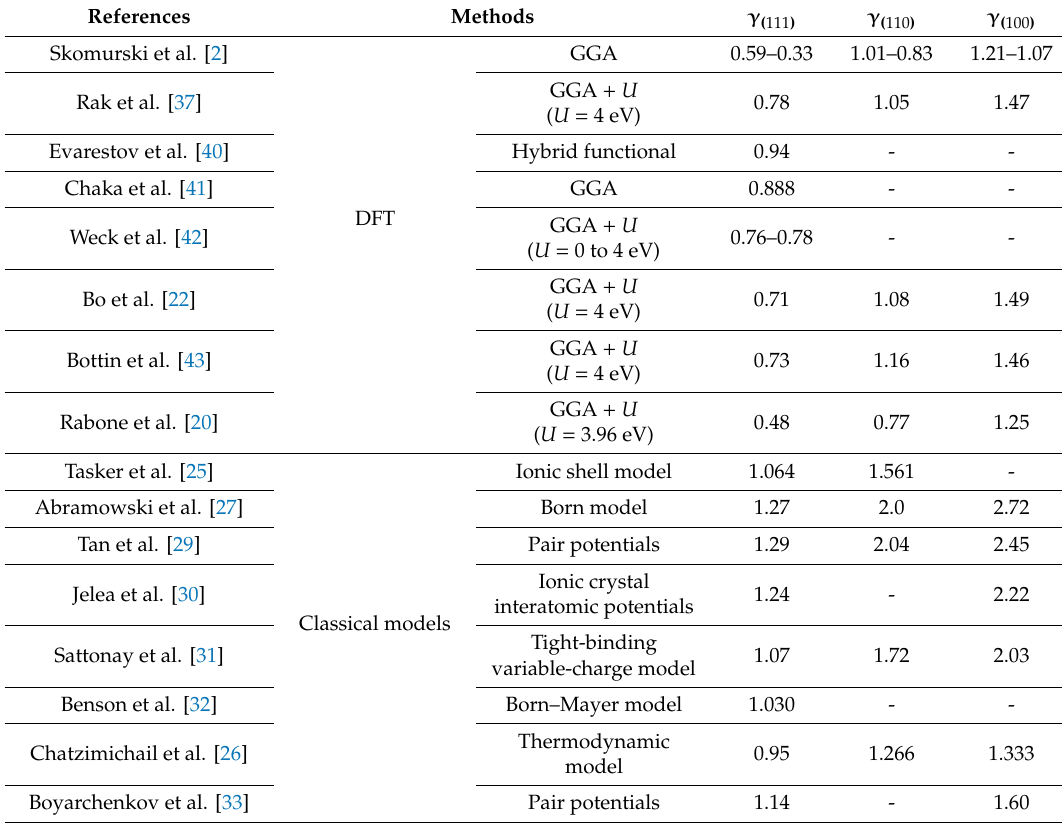
Table 2. UO 2 surface energies in units of J / m 2 .